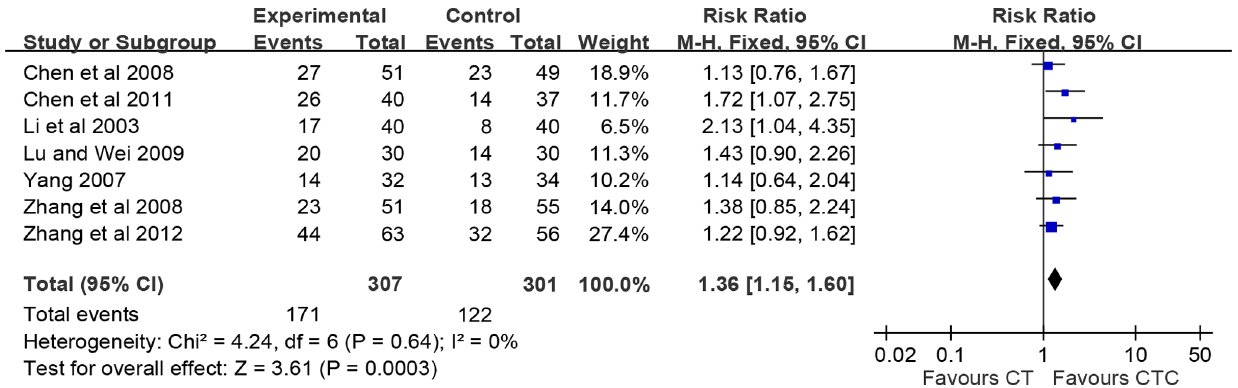
Figure 2. Number of patients with survival . one-year. Overall survivals estimated from meta-analysis of pairwise comparisons in the patients with chemotherapy combined Chinese herbal medicine (CTC, treatment group) versus patients in chemotherapy (CT, control group).